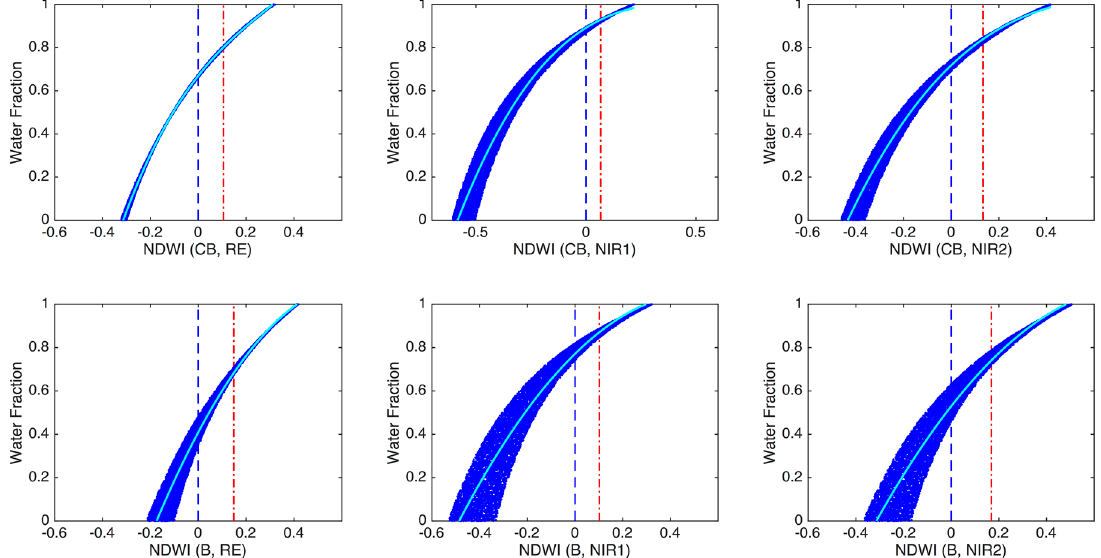
Figure 9. The regressions of normalized difference water index (NDWI) values with different band combinations obtained from synthetic WV-3 spectra against known water fractions; the pair of bands used for calculation of NDWI is indicated on each graph (CB and RE stand for coastal-blue and red-edge bands, respectively); zero-threshold and Otsu’s threshold are illustrated respectively with blue (dashed) and red (dot-dashed) lines.